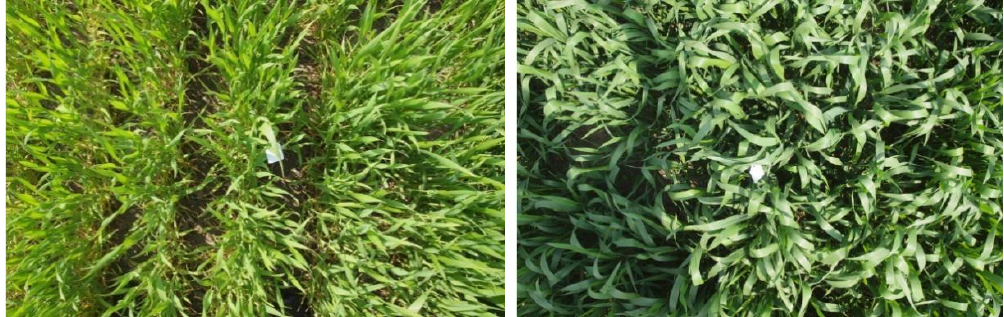
Figure 15. Photographs of wheat growth under different nitrogen application rate levels. (left: 150 kg/ha, right: 300 kg/ha).